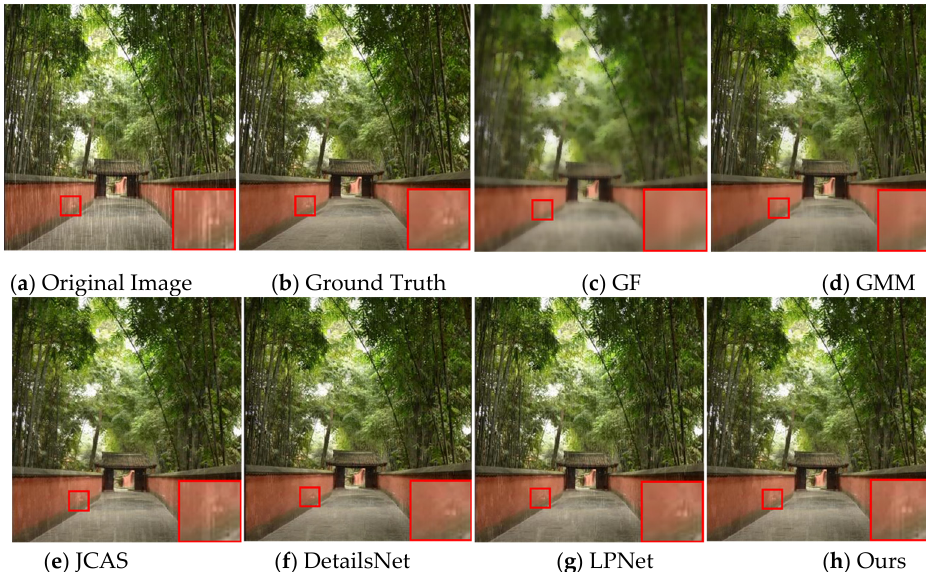
Figure 7 . The subjective visual effects of the synthetic image (“bamboo”) are compared in total. The first image is the synthetic rain image, the second image is the ground truth, and the following images are the results of GF, GMM, JCAS, DetailsNet, LPNet, and our method.